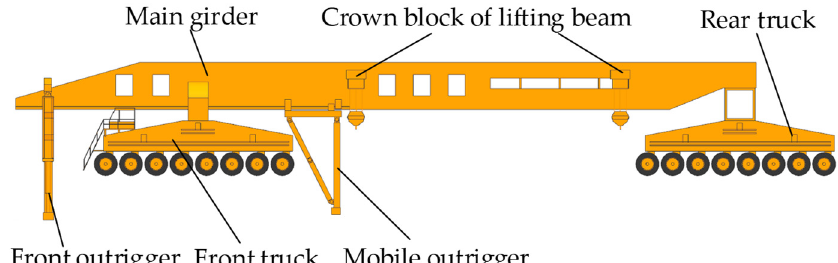
Figure 17. SJL900/32 mobile bridge erecting machine.